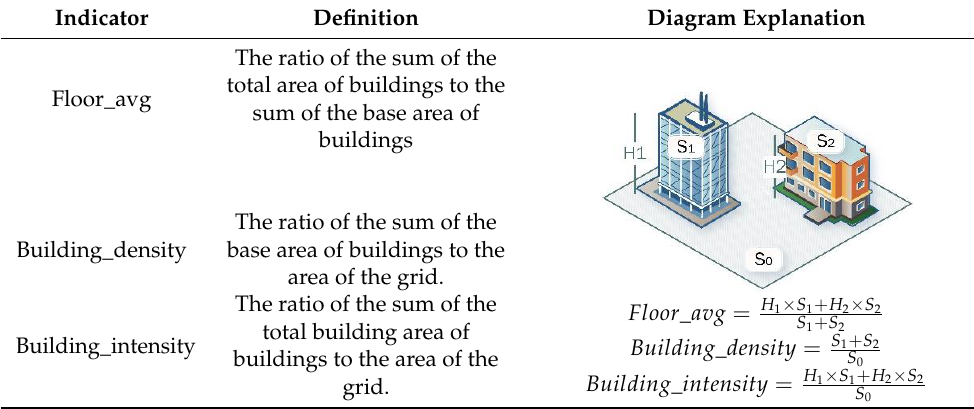
Table 2. Definition of building indicators in construction land grid.